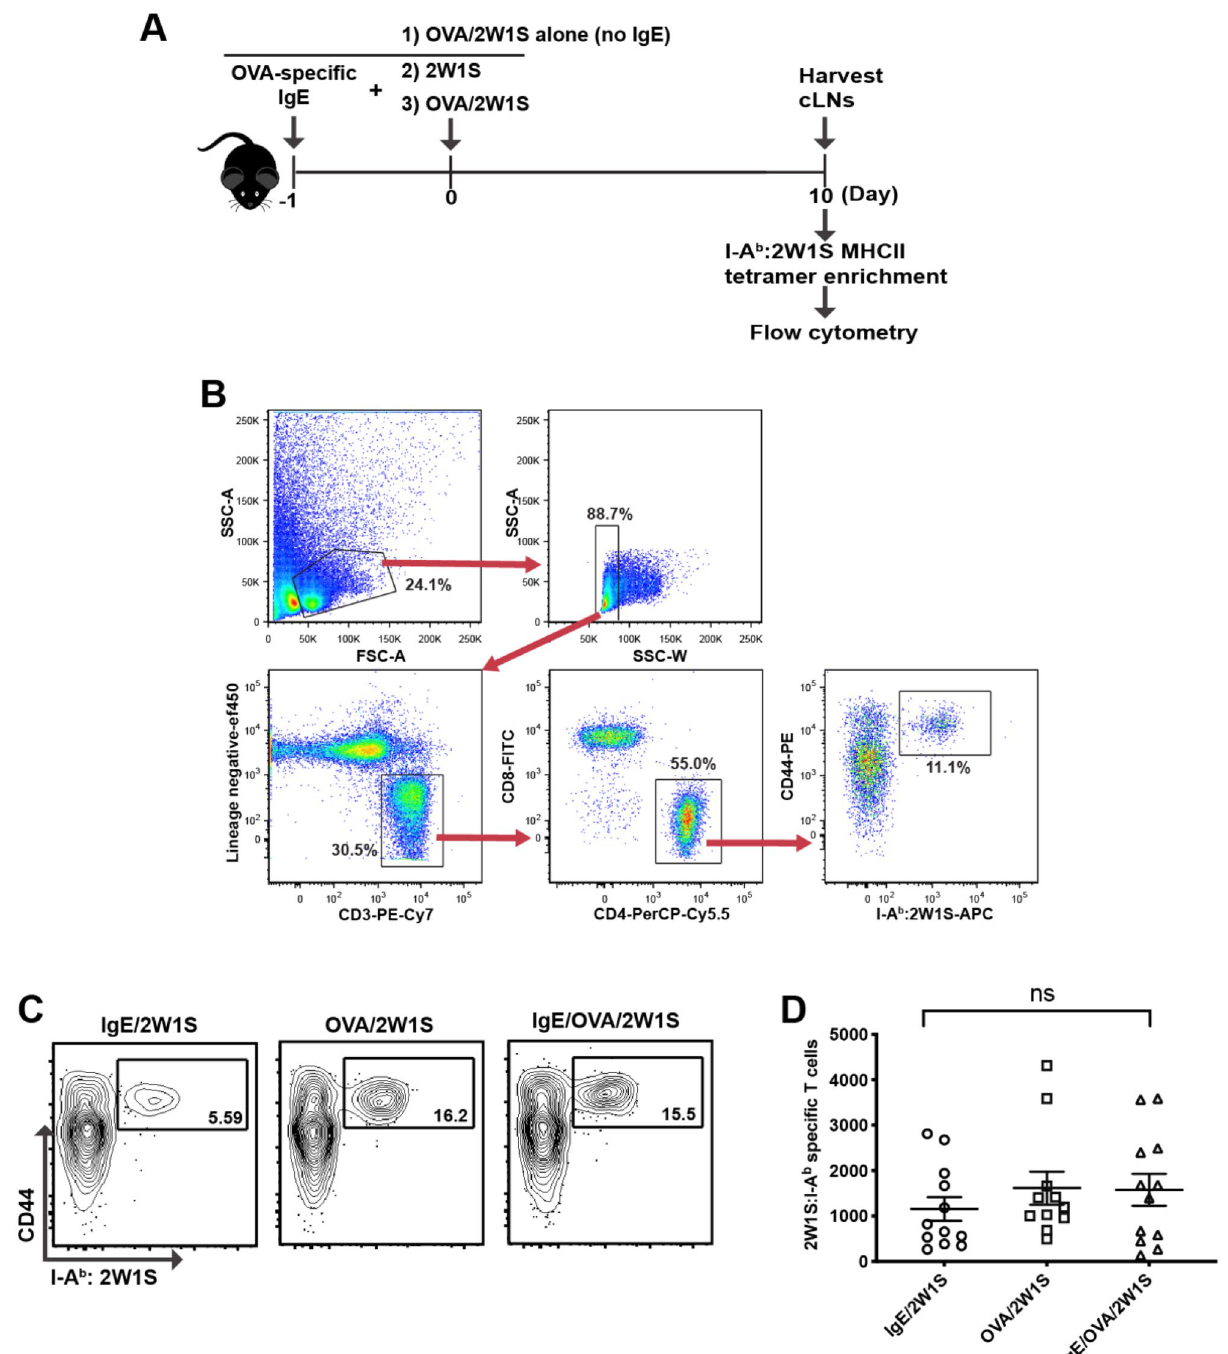
Figure 1. IgE-mediated mast cell activation does not result in increased numbers of endogenous antigen- specific CD4 + T cells. ( A ) Strategy for intradermal ear immunization to enumerate 2W1S-specific CD4 + T cells upon IgE/OVA-induced mast cell activation. ( B ) Gating strategy and representative flow plots of antigen-specific CD4 + T cells in the cervical draining lymph nodes (CLNs) 7 days post immunization. 2W1S-specific CD4 + T cells post enrichment were identified as lymphocytes by forward and side scatter properties and then doublets were excluded based on side scatter width (SSC-W). Singlets were stained for T cells by eliminating T cell lineage negative cells (CD11b-, CD11c-, F4/80-, CD19-), and gating on CD3ε + cell. Helper T cells were gated as CD4 + CD8α- cells. Finally, antigen experienced 2W1S specific cells were gated as CD44hi and I-Ab :2W1S- APC + . Percentages in each gate are indicated. ( C ) Representative flow plot of 2W1S-specific CD4 + T cells in the cervical draining lymph nodes (CLNs) 7 days post immunization for each group is shown. Percentage of 2W1S- specific CD4 + T cells post tetramer enrichment was indicated. ( C ) The total number of 2W1S-specific CD4 + T cells in the CLNs 7 days post immunization. Results are shown as mean ± SEM from 4 independent experiments n = 11–12 mice per group. Statistical analysis was performed using a Kruskal–Wallis test with Dunn’s